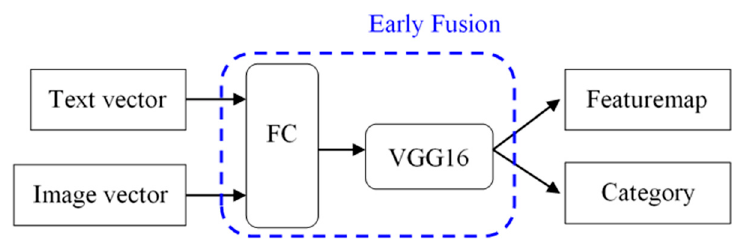
Figure 3. The architecture for early fusion of text and image features.